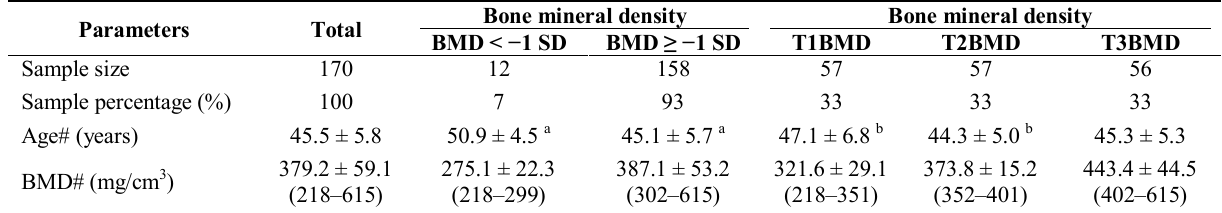
Table 2. Description of the sample depending on bone mineral density